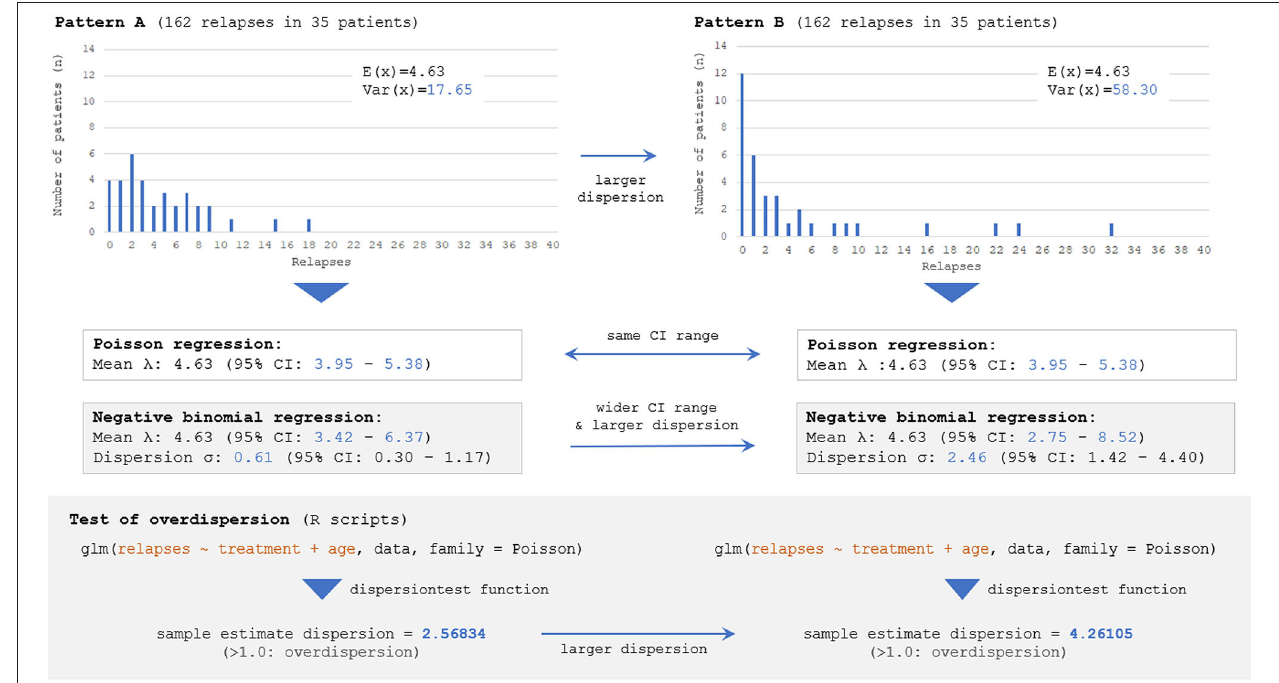
FIGURE 5 | Estimated 95% CI with different dispersions of dataset by Poisson and negative binomial models. Two different distributions with the same numbers of overall events (162 total relapses as outcome measure) and participants ( n 35), but with different distributions of event frequency showing distinct dispersion levels = [ V ( X ) 17.65 for Pattern A vs. 58.30 for Pattern B ], are considered. The follow-up period is regarded to be the same (e.g., 1 or 2 years) among 35 patients. The = Poisson model can yield only a single 95% CI for both distributions because of the characteristics of the Poisson distribution, and the information regarding the skewness could not be accounted for. Meanwhile, negative binomial distributions can yield two distinct 95% CI for the two distributions, reflecting the different skewness. The overdispersion test by R Statistics revealed that the estimated dispersion levels from these two distributions were both larger than 1.0, suggesting that negative binomial models would be a better fit than Poisson for